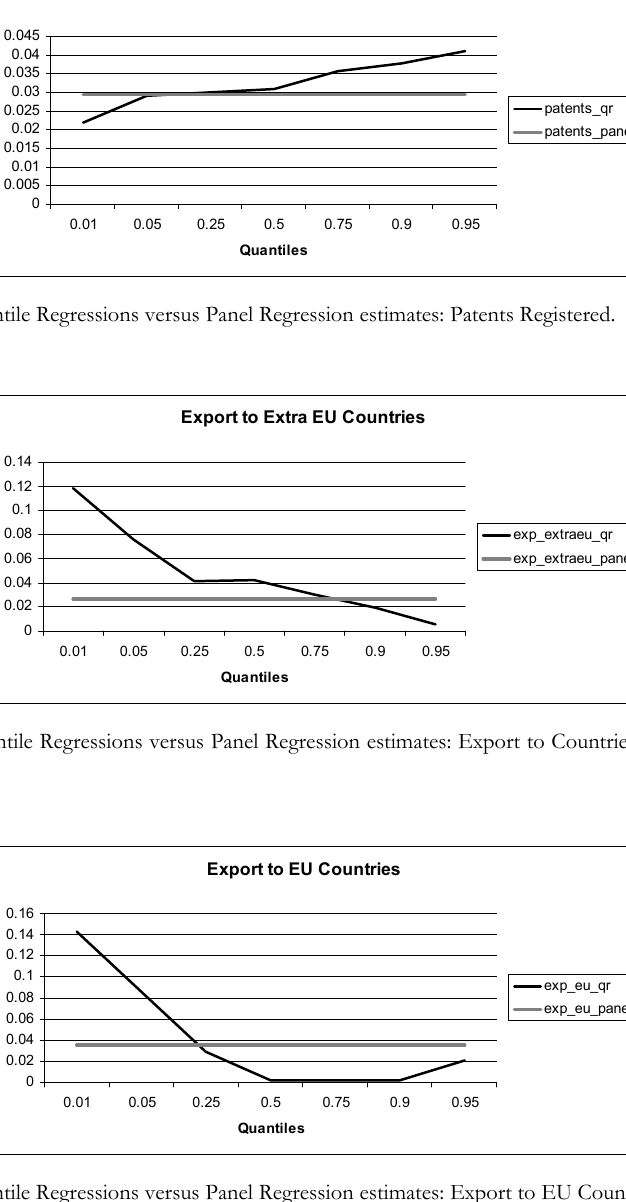
Figure 8 – Quantile Regressions versus Panel Regression estimates: Export to EU